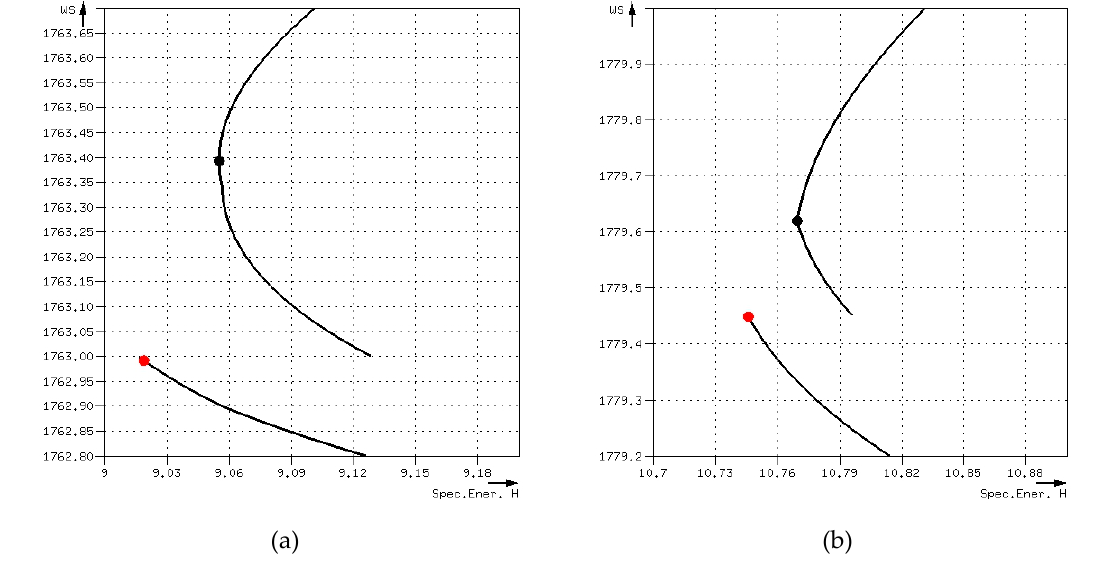
Figure 17 . Dataset 3: Critical depths of case 5 ( a ) section 9 and ( b ) section